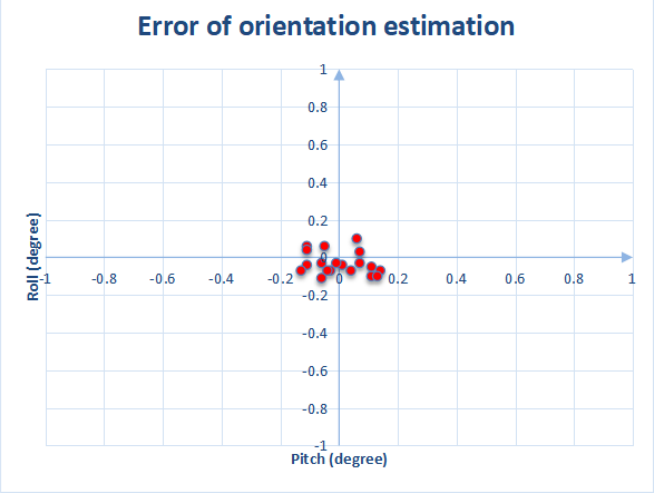
Figure 36. Orientation estimation error. It can be seen that the estimated orientation is very close to the inertial navigation